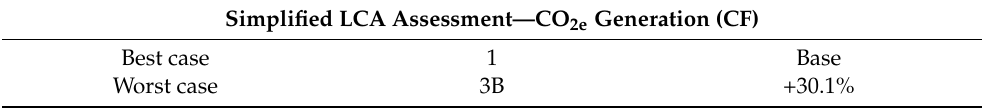
Table 36. Most centralized production compared to the most globalized scenario. CF measured in CO 2e